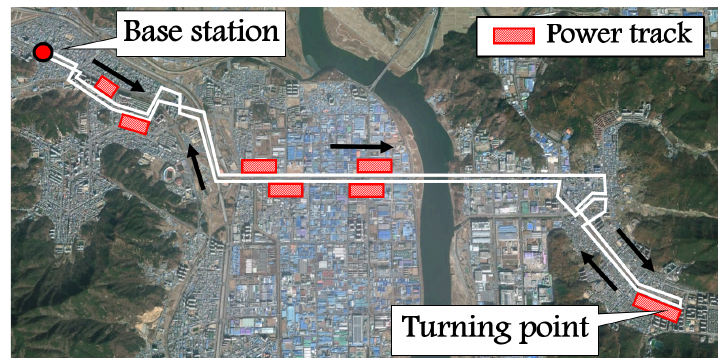
Figure 10. An example of the optimization problem for the Gumi City case (for k =